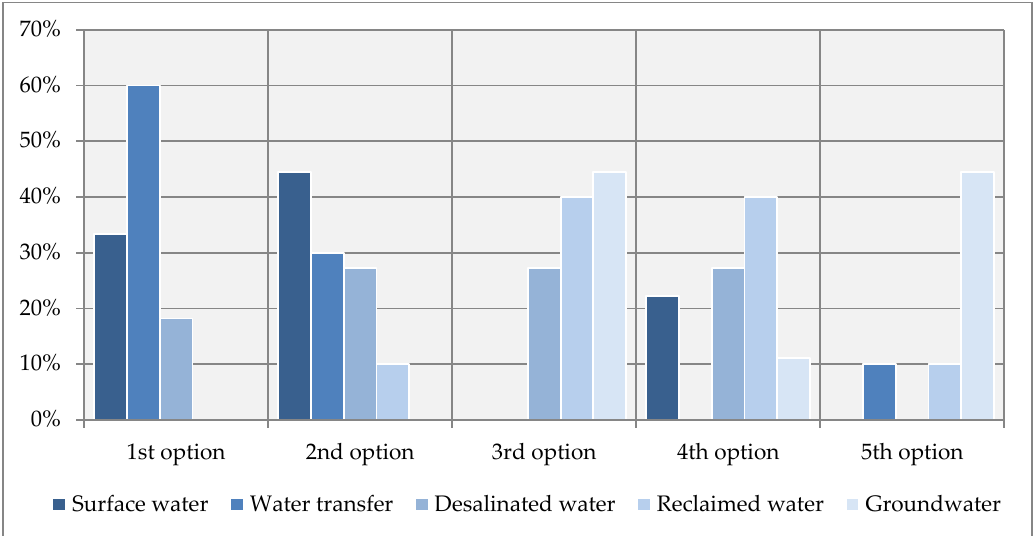
Figure 6. Priority of water use for irrigation according to supply sources regardless price.